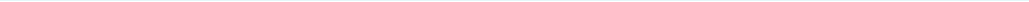
Figure 3: Disability insurance benefits for all 54 recipients as reported by FISO (2005 to 2014). Each white horizontal line belongs to one pa- tient, the bubbles represent the monthly disability allowance (pension), the triangles show the year of transplantation of a given patient and the asterisk the year of death if applicable. The size of the bubble represents the amount of the monthly pension. Each payment after transplanta- tion was compared to the last payment before transplantation and color coded. Blue: less than 10% change of the monthly allowance post- transplant. Red: increase of the allowance of more than 10%. Green: decrease of the allowance by more than 10% after transplantation. The lines highlighted on top in pink emphasise those 13 patients transplanted in 2015 for whom FSIO data is not available after transplantation.